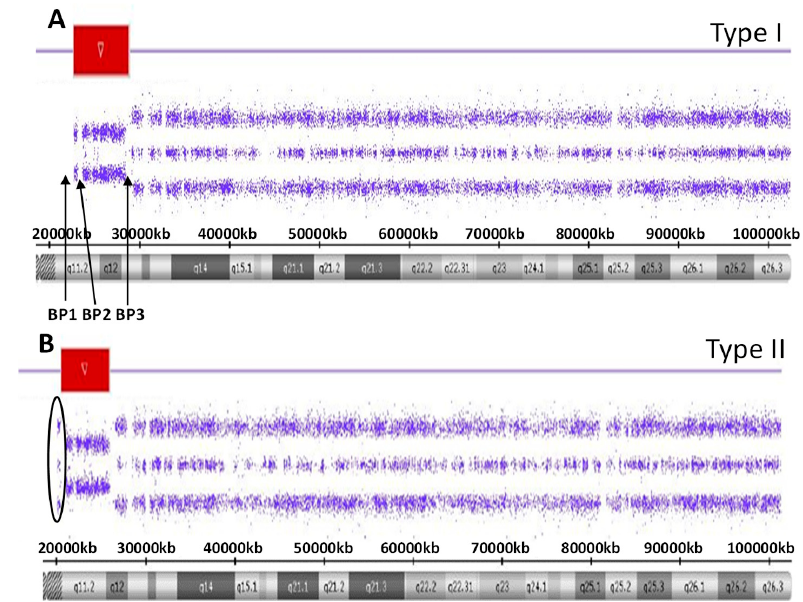
Figure 1. High-resolution chromosome microarray results for the larger typical 15 q11-q13 Type I deletion involving breakpoints BP1 and BP2 ( A ) while the smaller typical 15q11-q13 Type II deletion involving breakpoints BP2 and and BP3 ( B ). The red-colored bars represent the deletion region for both the Type I and Type II deletions.